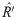
Measured performance against Shannon upper bound.
R′^ is plotted against R¯(k,f0,f1), R¯(k,f0^,f1^) for each condition. A line at α = 0:5 showing 50% of the Shannon bound is shown.